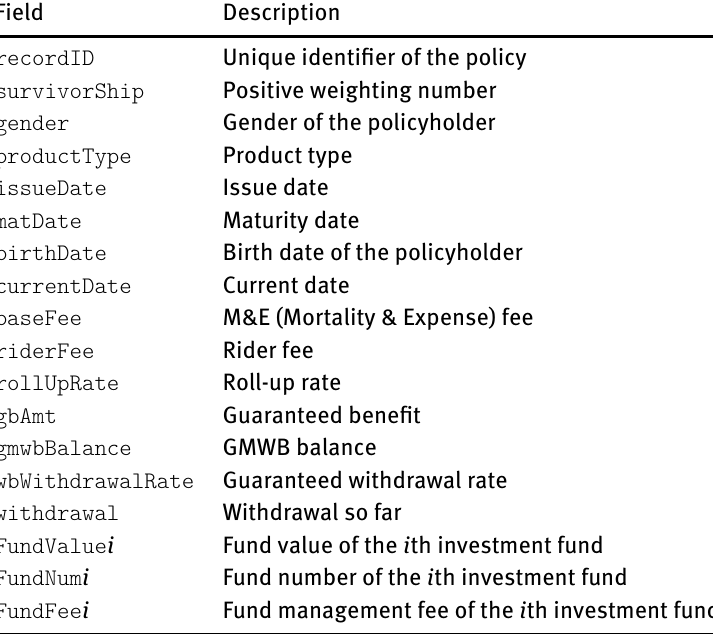
Table 5: Description of the policy fields.